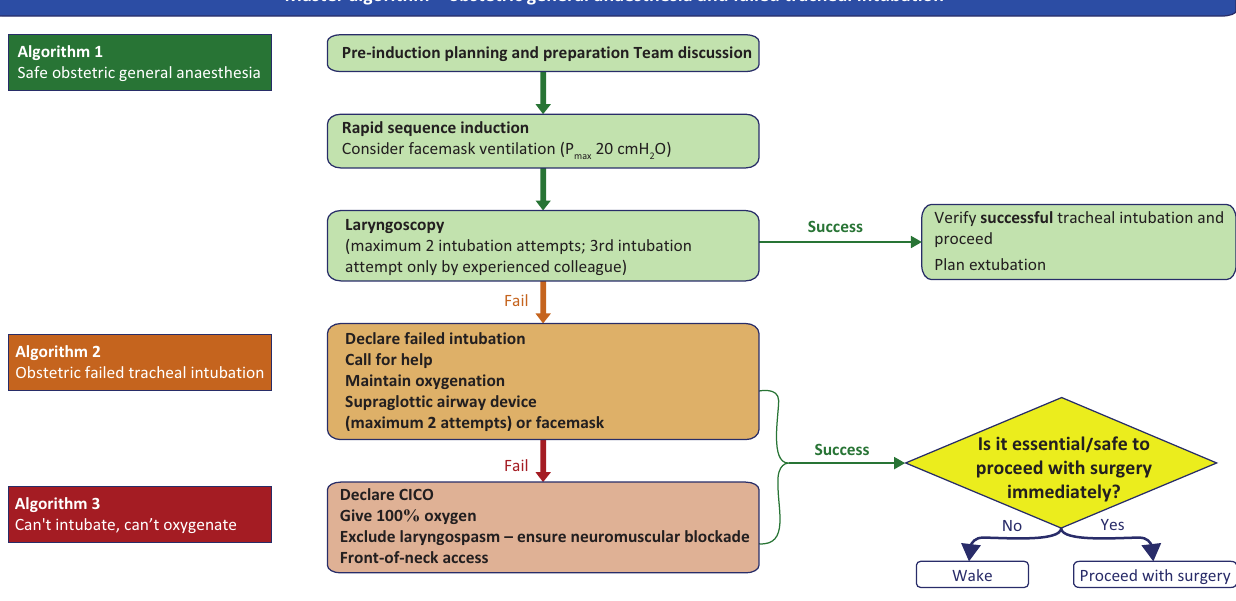
FIGURE 2: Obstetric general anaesthesia and failed tracheal intubation.